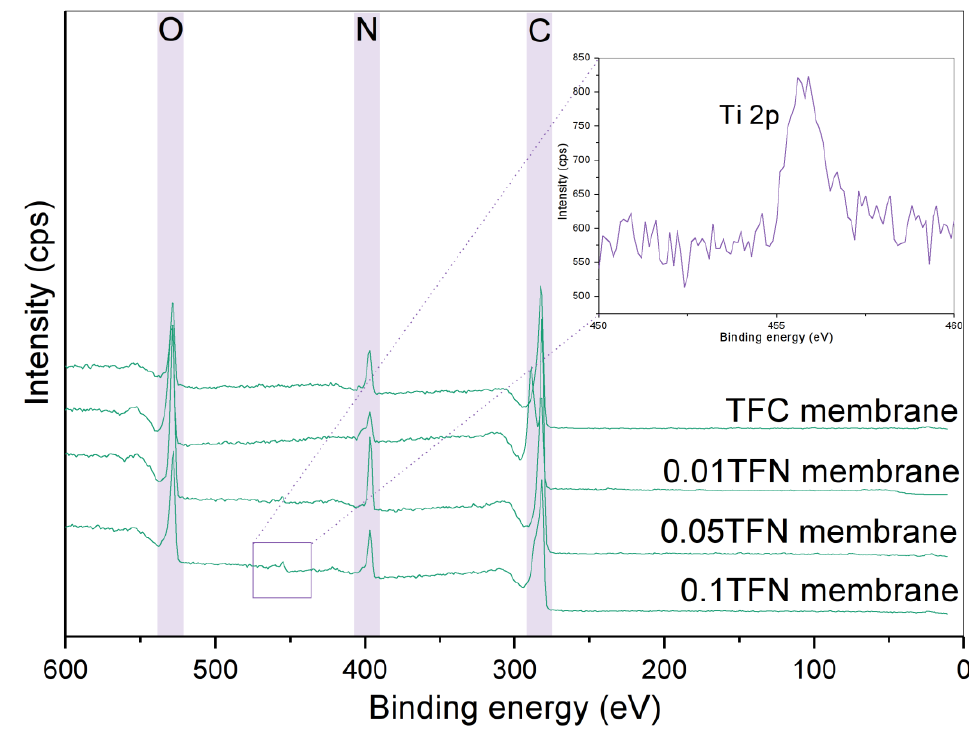
Figure 7. XPS spectra of TFC and TFN membranes (inset: the magnified XPS spectrum of the Ti 2p region).